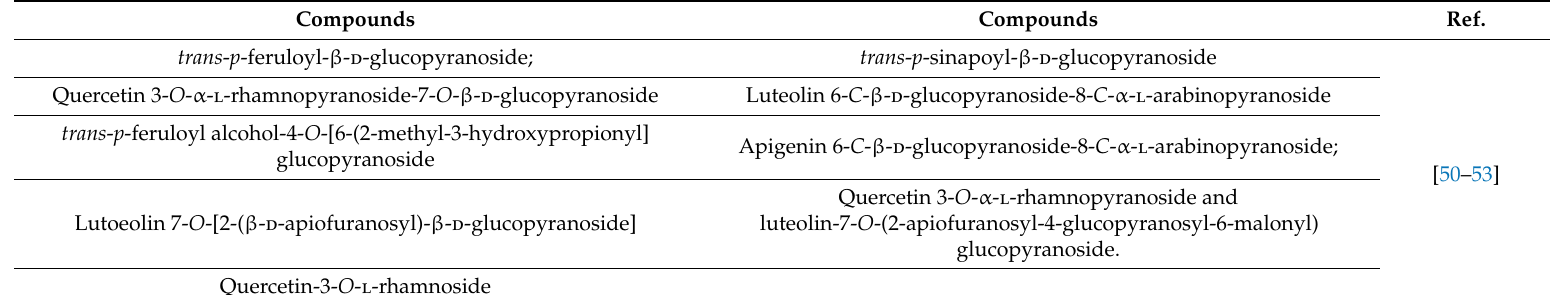
Table 4. The flavonoid and phenolic acid fraction of red pepper